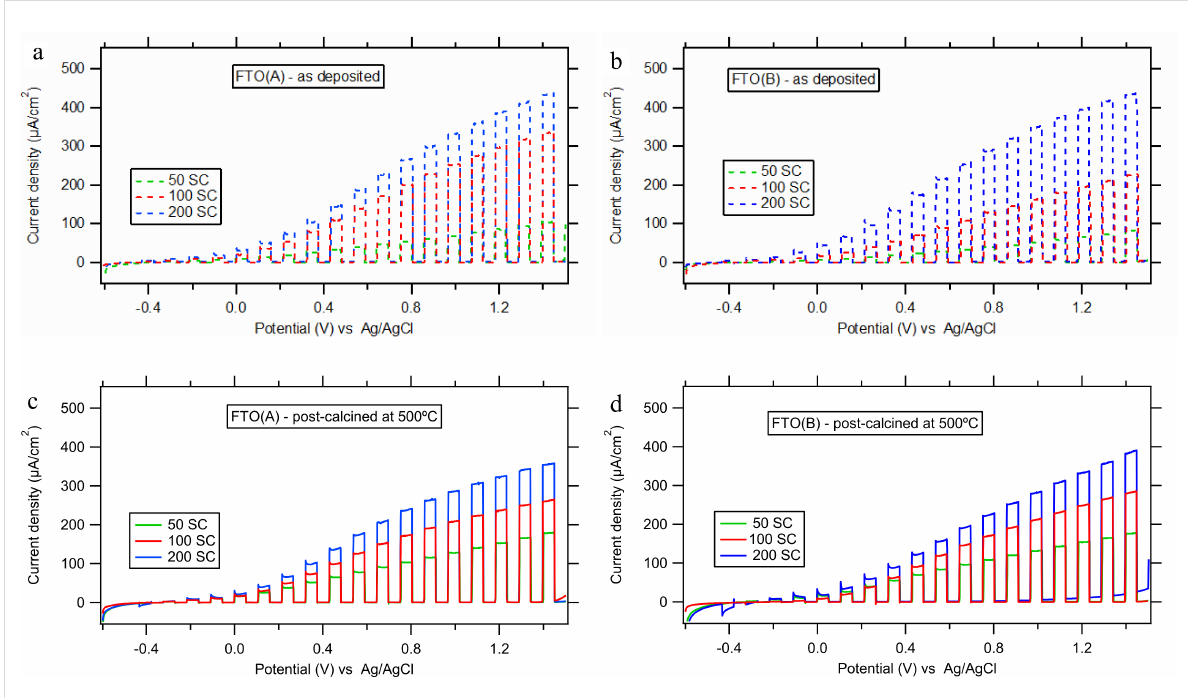
Figure 3: Linear sweep voltammetry under intermittent UV light (Hg lamp 320–380 nm; intensity 7.5 mW/cm 2 ). Precursor: 0.05M TAA, deposition temperature: 450 °C, electrolyte solution: 0.1 M Na 2 SO 4 (pH 10), dark/light interval: 10 s. (a,c) Films deposited on FTO(A) 50, 100 and 200 SCs. (b,d) Films deposited on FTO(B) 50, 100 and 200